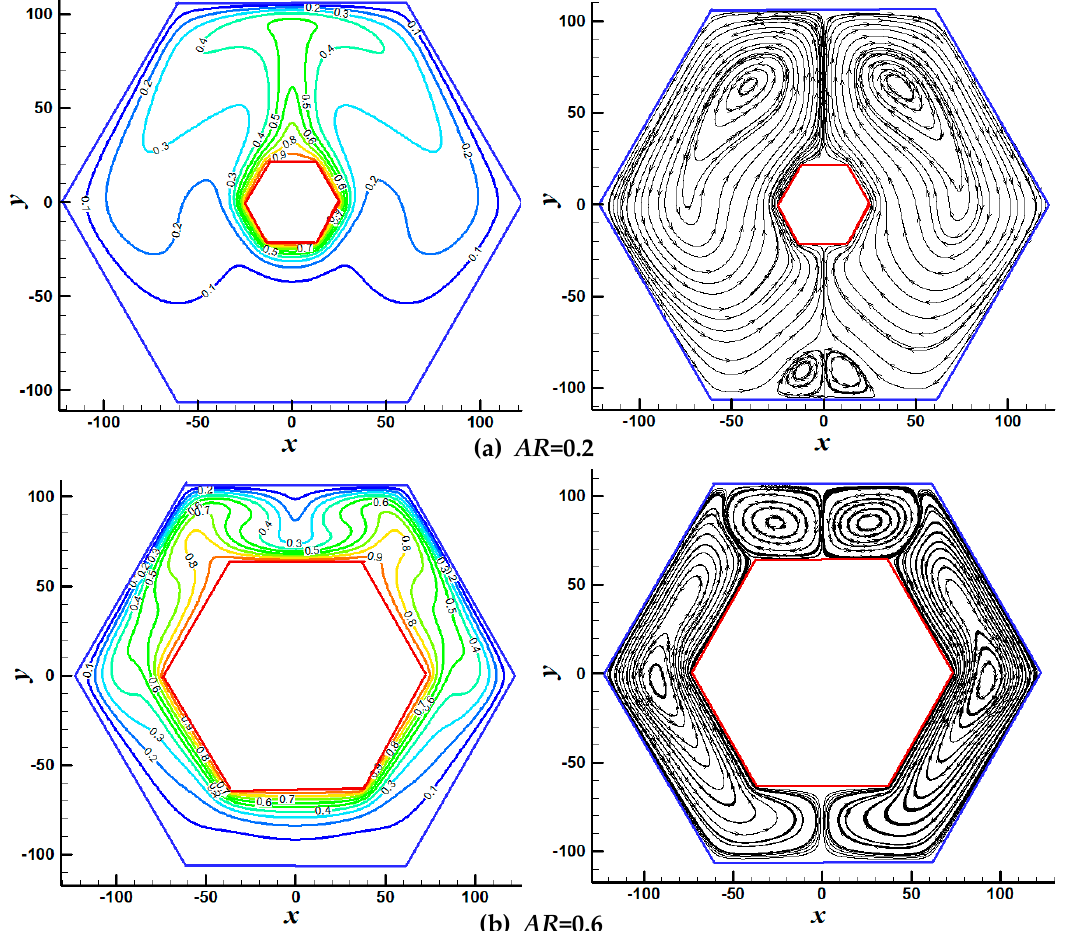
Figure 6. Isotherms (left side) and streamlines (right side) patterns obtained from ANSYS-Fluent ® software for the values of AR = 0.2 ( a ) and AR = 0.6 ( b ) when Ra = 10 6 .